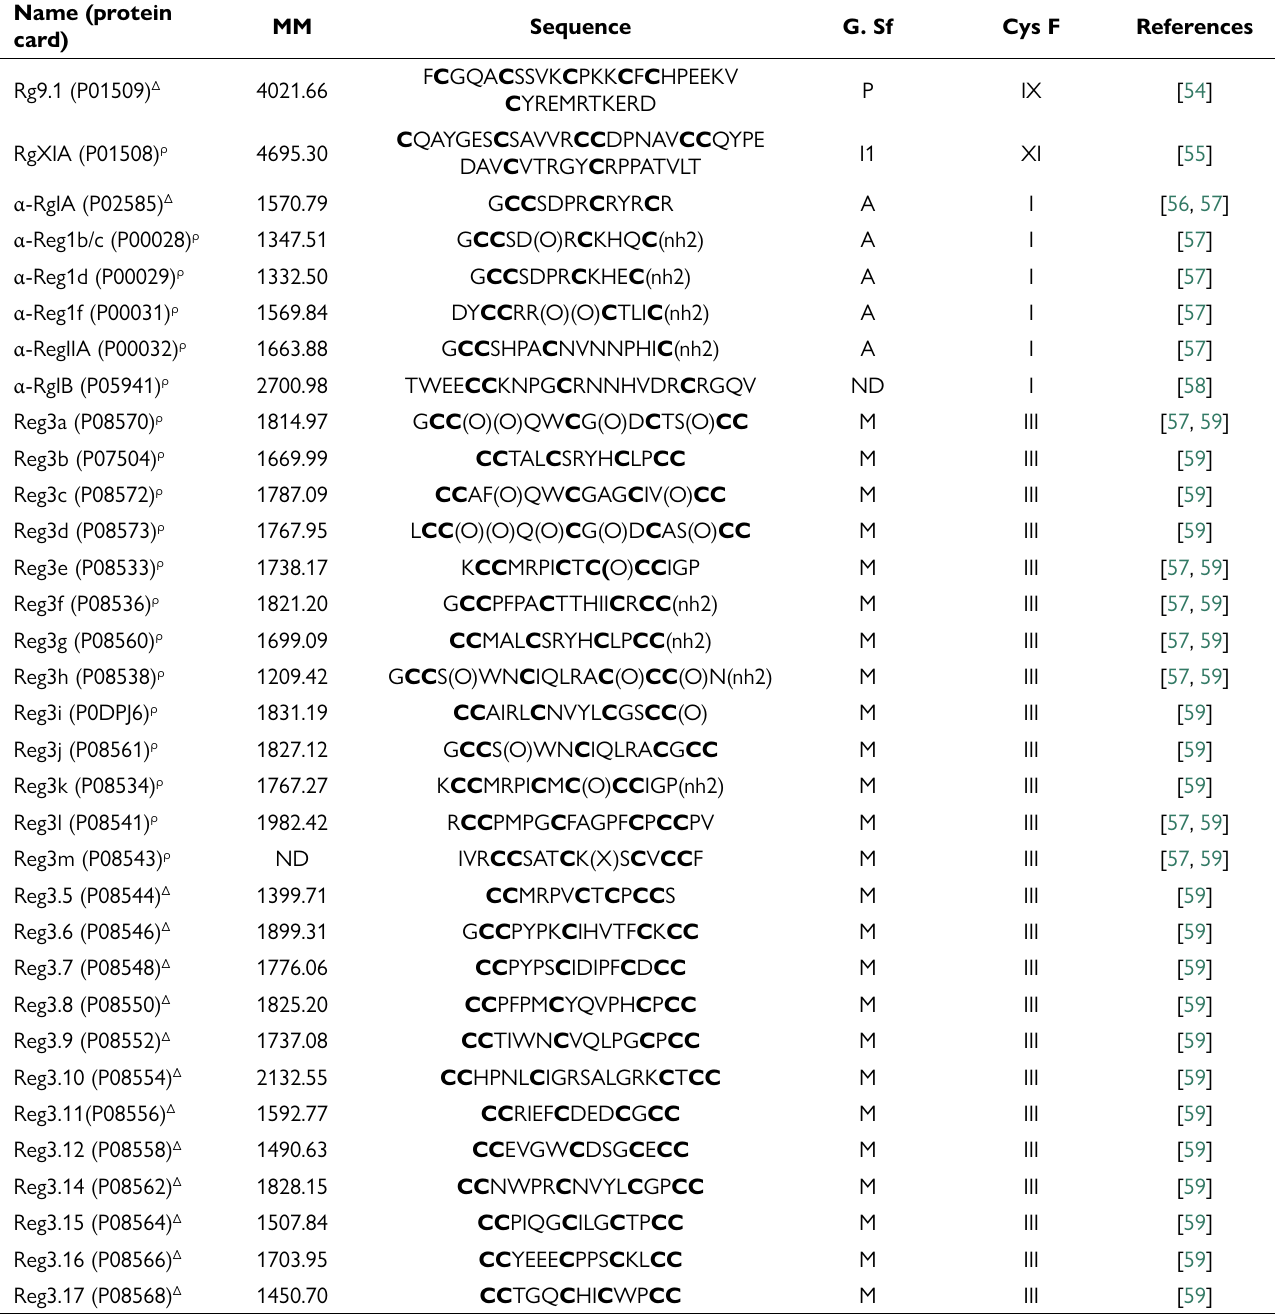
Table 5. Conotoxins identified in the venom of Conus